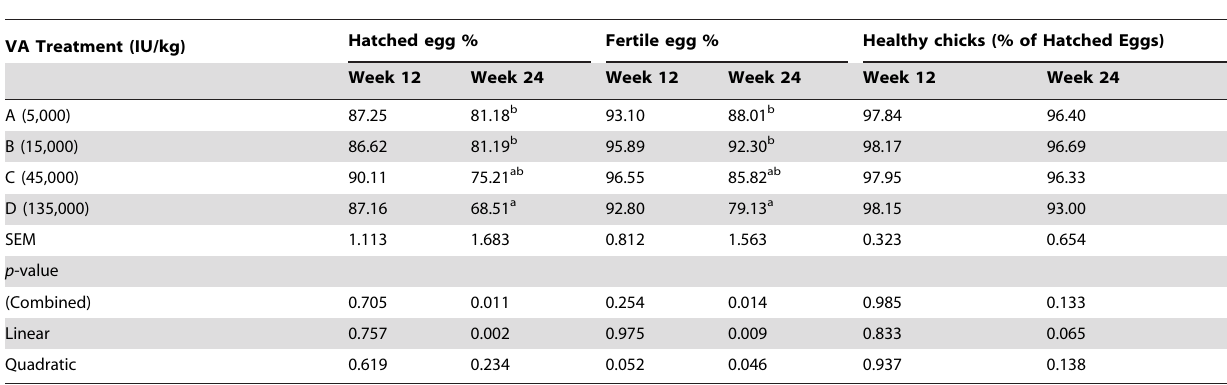
Table 5. Fertility and hatchability at week 12 and week 24 of the experiment.